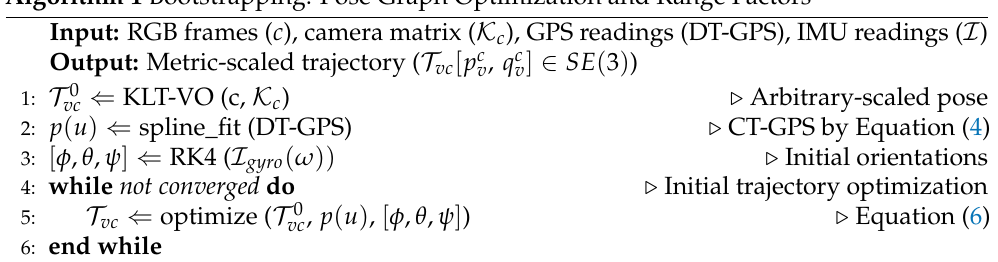
Algorithm 1 Bootstrapping: Pose Graph Optimization and Range